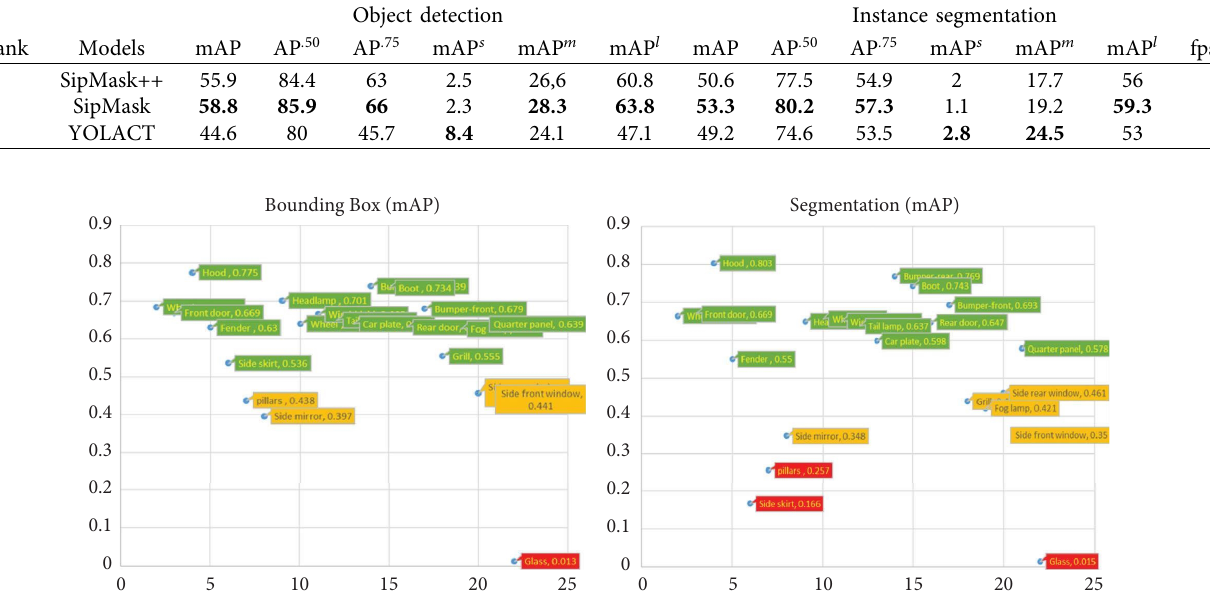
Figure 10: Class-level mAP values for the YOLACT algorithm.